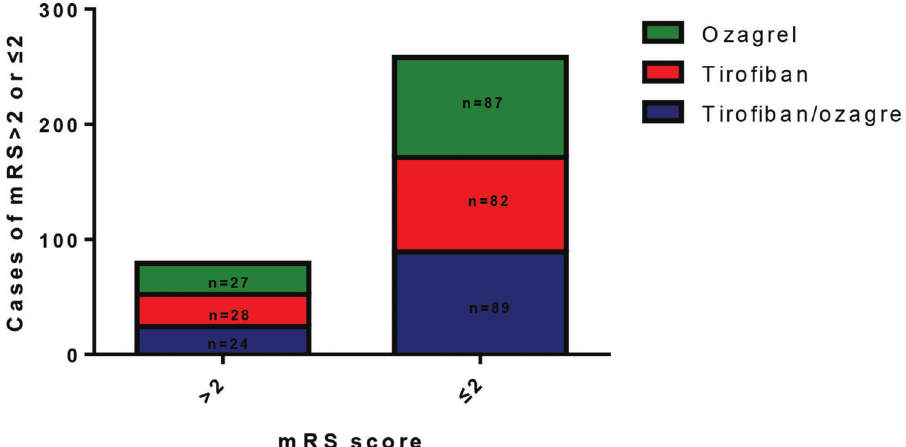
Figure 2 - mRS scores for patients in different groups.